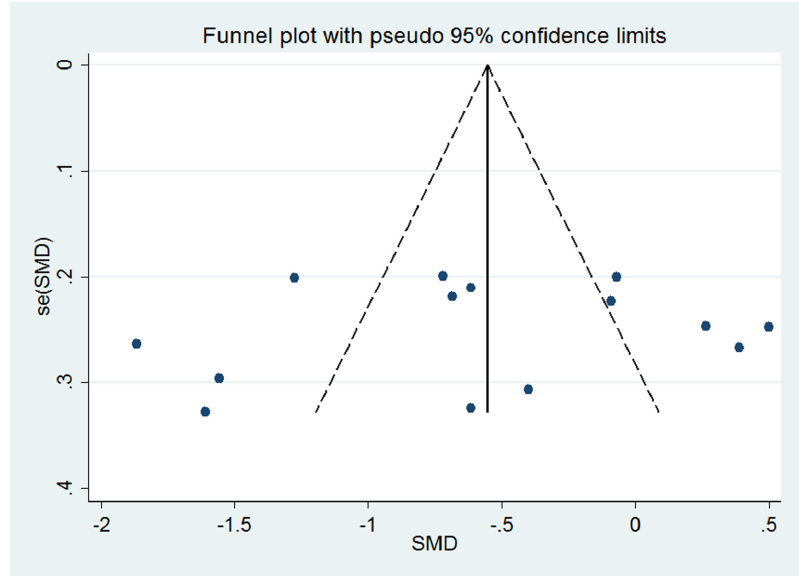
Figure 5. Funnel plot for the analysis of serum zinc level and preeclampsia (PE).